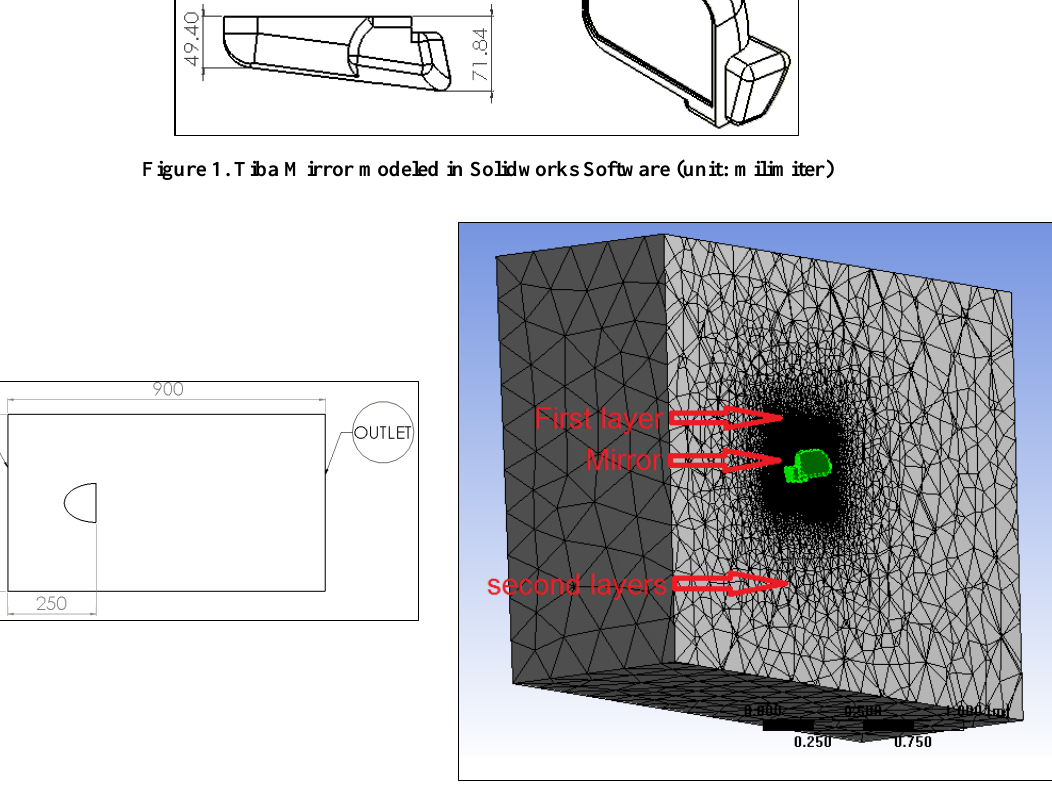
Figure 2. Two size meshs which were used, and size of coridor (unit: